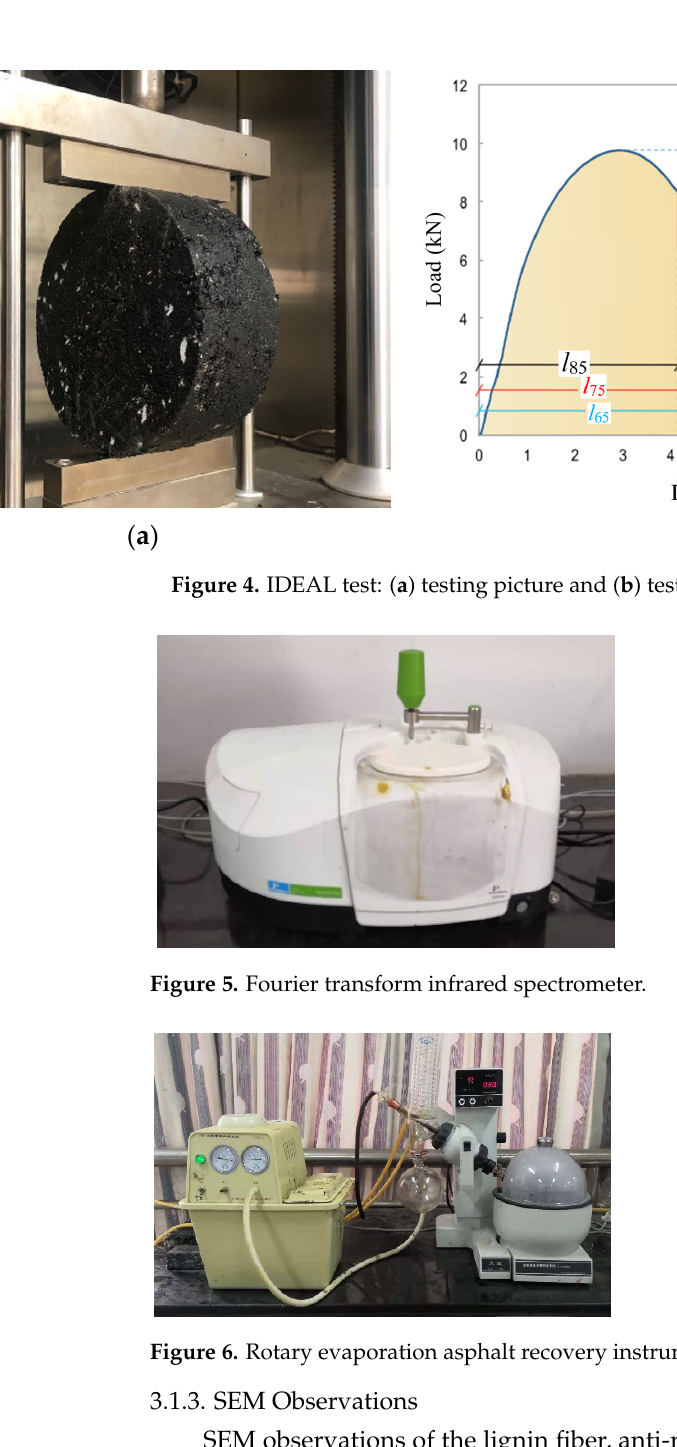
Figure 4. IDEAL test: ( a ) testing picture and ( b ) testing curve.